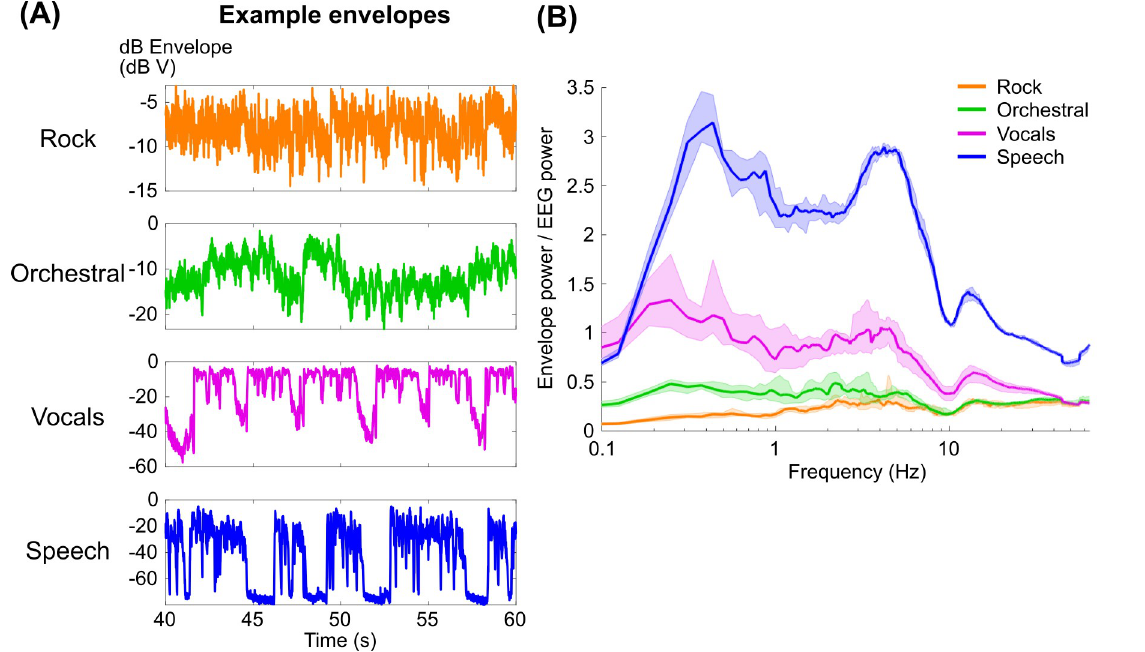
Fig 1. (A) 20 seconds of example dB envelopes for each stimulus type. (B) Power spectra of the dB envelopes using Welch’s method with a 16 s Hamming window and half-overlap after normalizing by the average EEG spectrum for all subjects (see Methods). Lines indicate the median across stimuli of each type, and shaded regions indicate 95% quantiles of the distribution of 1000 bootstrapped median values.